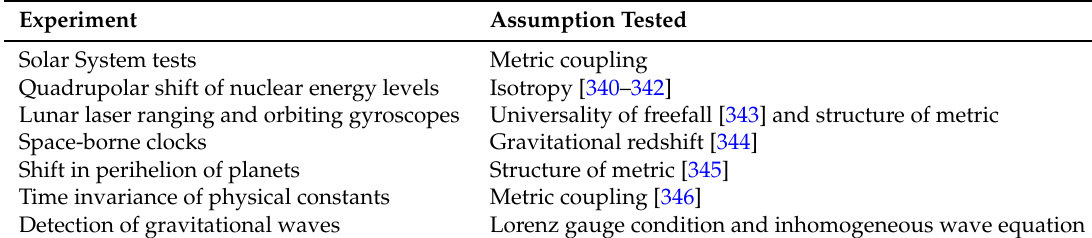
Table 4. What we are actually testing. Experimental tests of General Relativity (GR) often probe more than one assumption, and isolating the effects is a challenge in